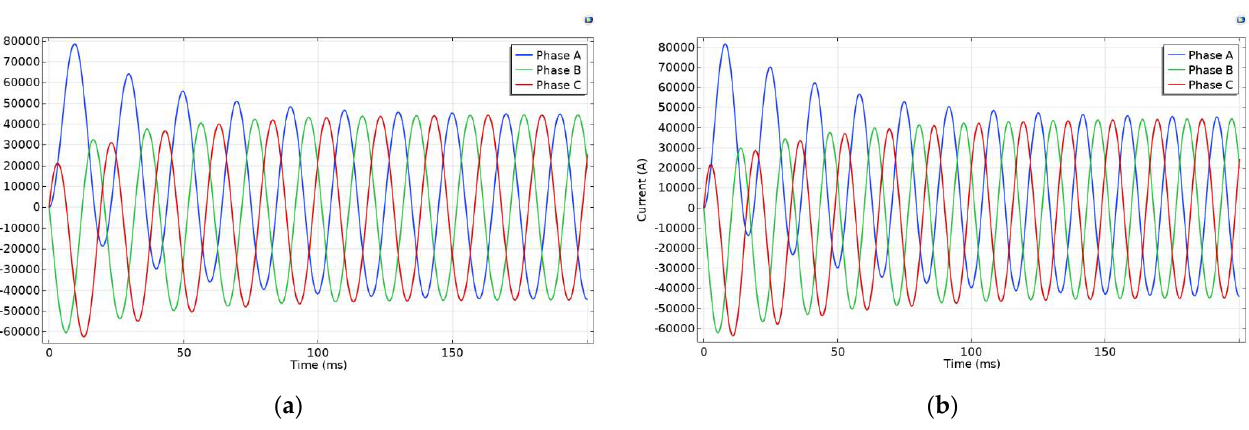
Figure 1. Simulation currents for each phase at: ( a ) 50 Hz; ( b ) 60